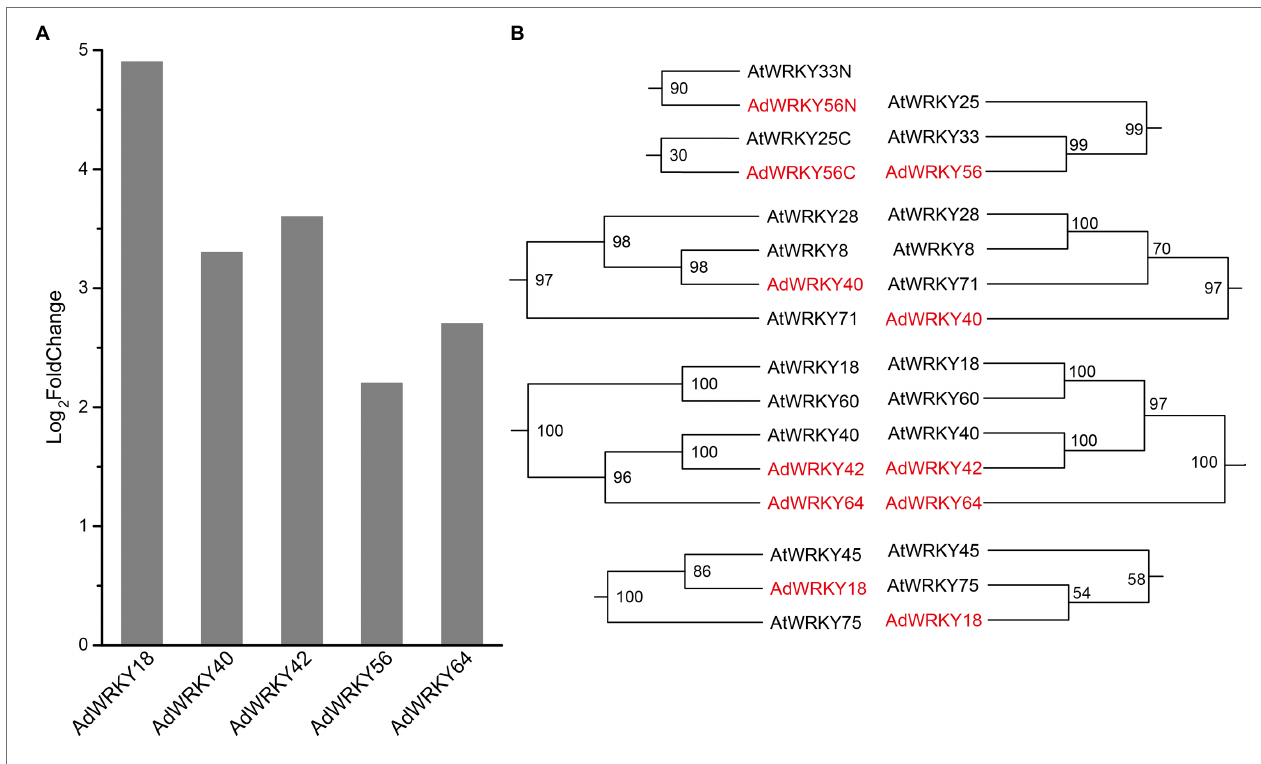
FIGURE 1 | Differentially expressed AdWRKYs and phylogenetic trees. (A) The differential gene expression based on RNA-seq (Brasileiro et al., 2015). (B) The maximum likelihood trees construct using WRKY domains and full-length proteins.